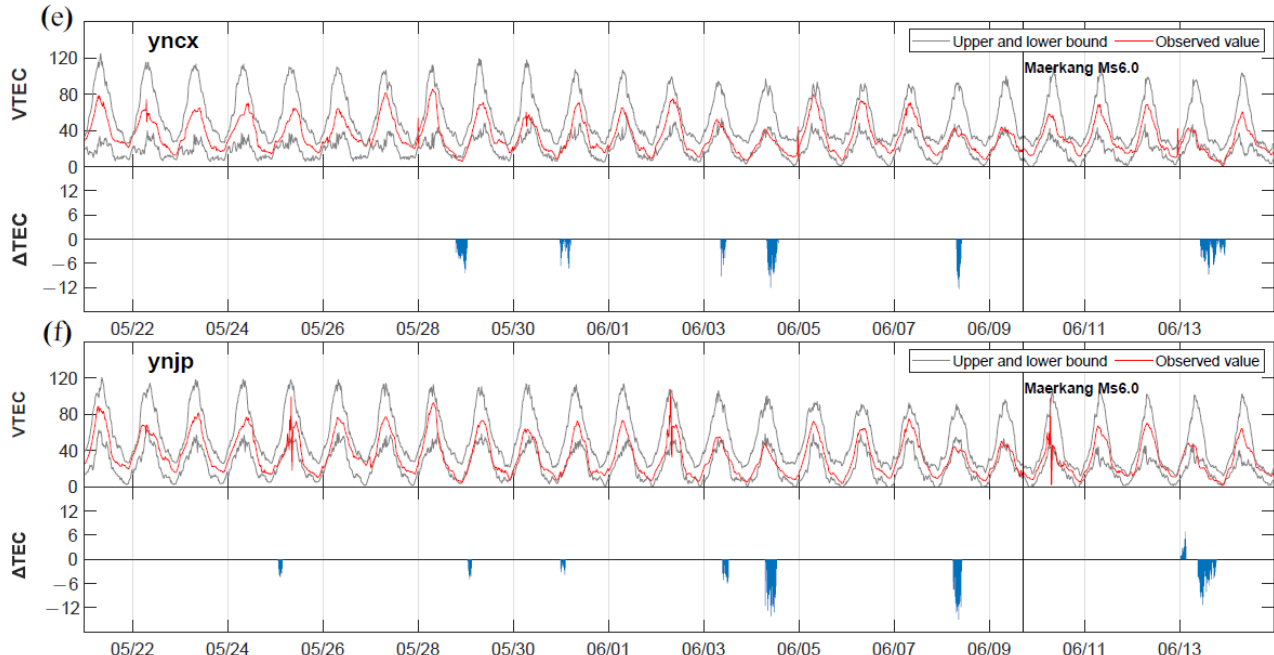
Figure 4. Temporal variations of GPS TEC from six GPS stations in and around the epicenter. ( a ) Maerkang station, ( b ) Xiaojin station, ( c ) Ganzi station, ( d ) Songpan station, ( e ) Chuxiong station, and ( f ) Jinping station. The time of earthquake is annotated by the black line, the upper and lower bounds are shown in gray, and observed values are shown in red. The abnormal values are shown in blue, represented as ∆ TEC.